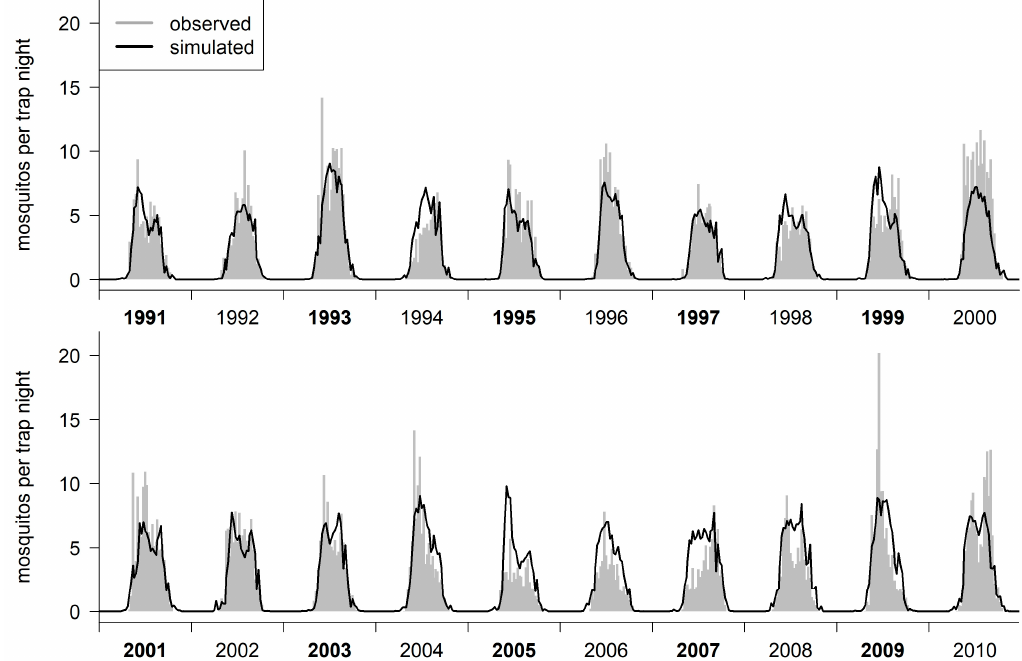
Figure 2. Standardized weekly averaged observation data and final model results. Years written in regular type indicate the years for the training data set; years in bold type indicate the test data set.